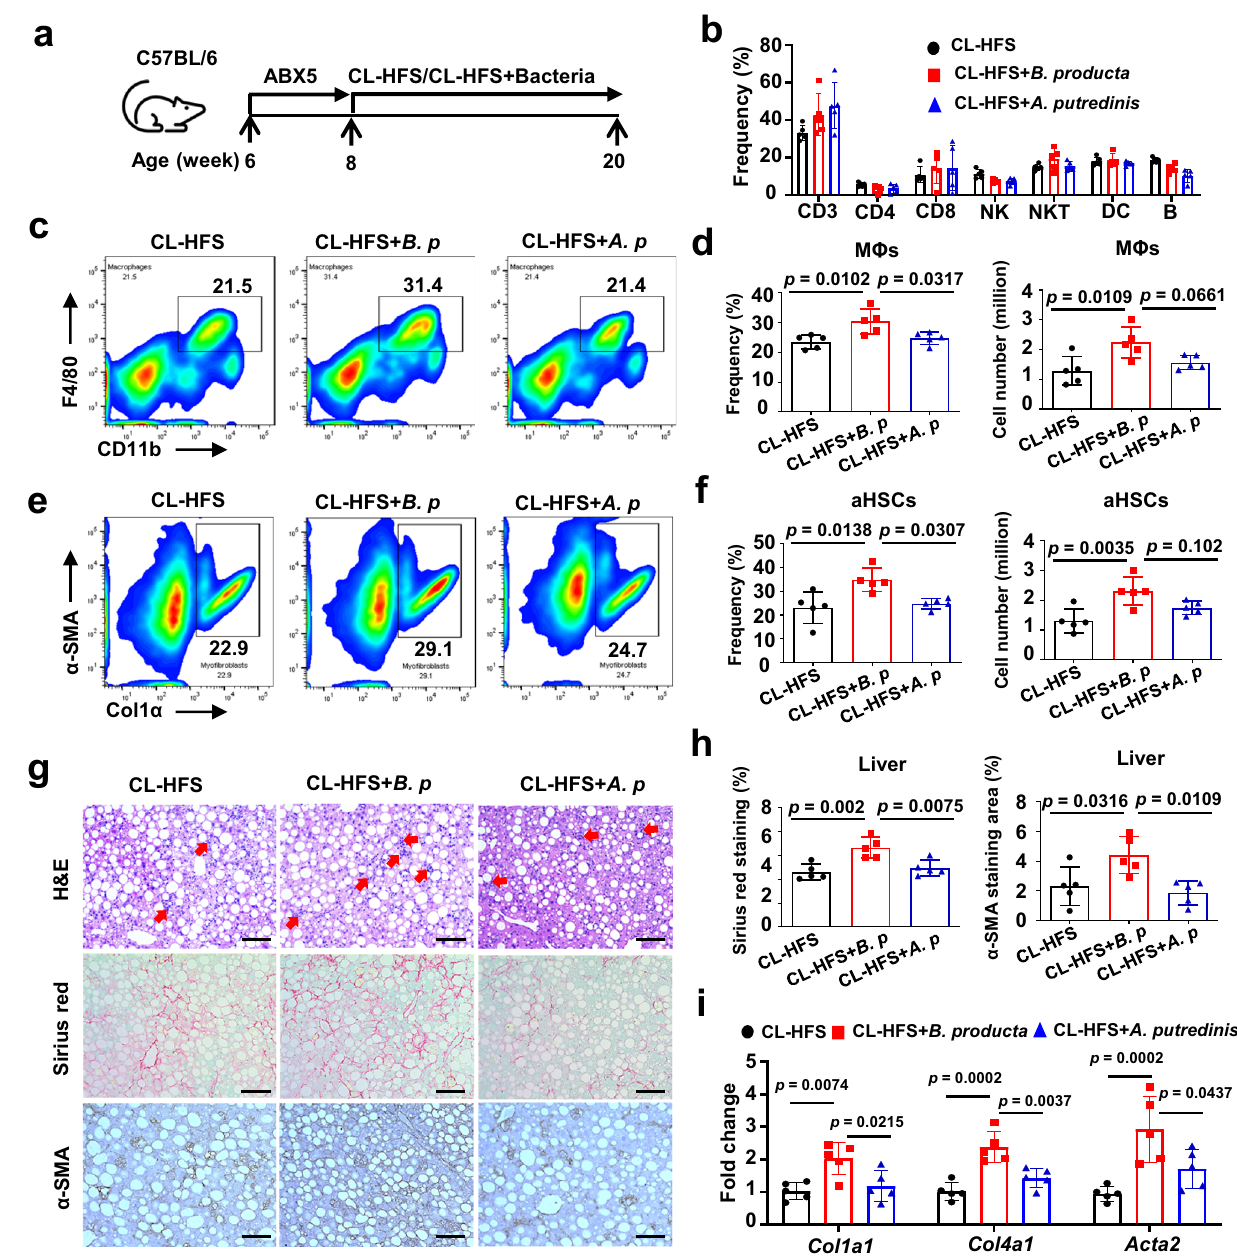
Fig. 5 | B. producta repopulation promotes CL-HFS-induced liver fi brosis in association with modulation of liver-resident M Φ s. a An outline depicting gut microbiota sterilization and bacterial repopulation. Six-week-old WT C57BL/6J mice received ABX5 orally in drinking water for two weeks to deplete intestinal bacteria,thenreceivedCL-HFSandsimultaneous Blautiaproducta (ATCC27340)or Alistipes putredinis (ATCC 29800) repopulation by oral gavage twice a week at a dose of 3×10 8 CFU/mouse in 200 µ l of PBS. Twelve weeks later, all mice were euthanized to harvest livers and isolate hepatic NPCs for the following studies. b The frequencies of distinct hepatic immune cells. Liver NPCs underwent fl ow cytometryto de fi ne the frequenciesof liver-resident CD3 (CD3 + ),CD4 (CD3 + CD4 + ), CD8 (CD3 + CD8 + ), NK (CD3 - CD49b + ), NKT (CD3 + NK1.1 + ), DCs (CD11b + CD11c + ), and B cells (CD3 - B220 + ). c Representative frequencies of liver-resident M Φ s in NPCs. d Mean frequency (left) and absolute number (right) of hepatic M Φ s in c . Data showed that repopulation with B. producta , but not A. putredinis , increased the frequency of hepatic M Φ s in CL-HFS-fed mice. e Representative frequencies of